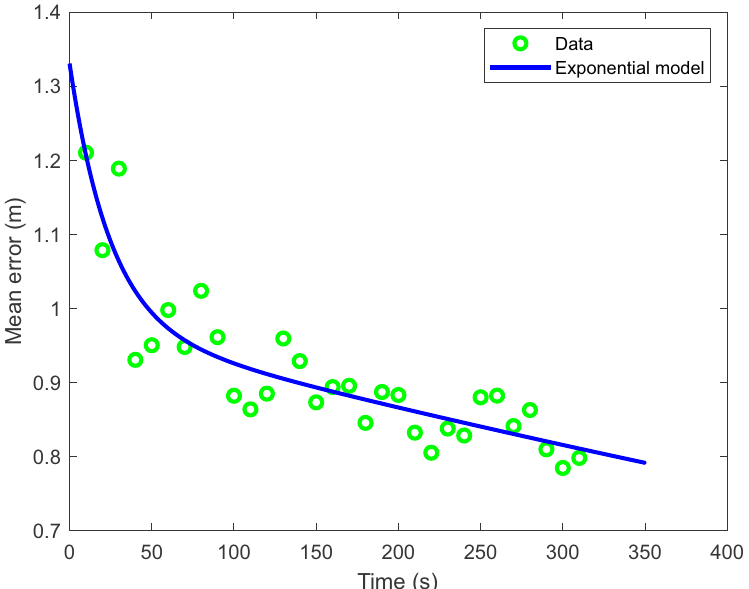
Figure 8. The mean localization error as a function of time or the travelled distance. The decrease of error can be described by an exponential model e = 0.35 exp ( − 0.04 t ) + 0.98 exp ( − 0.0006 t ) with the coefficient of determination R 2 =